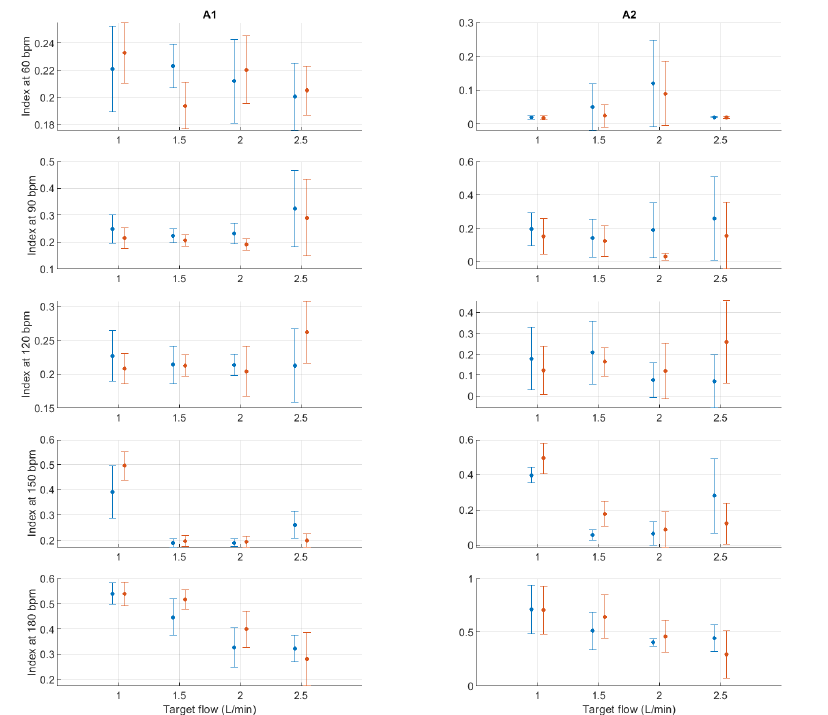
Figure A16. Mean and standard deviation of detrended fluctuation analysis indices extracted from pulse rate variability under different stroke rates (SR) and target flows (TF, TF below 2.5 L/min) conditions, and measured from the radial (blue) and deep palmar arch (orange)